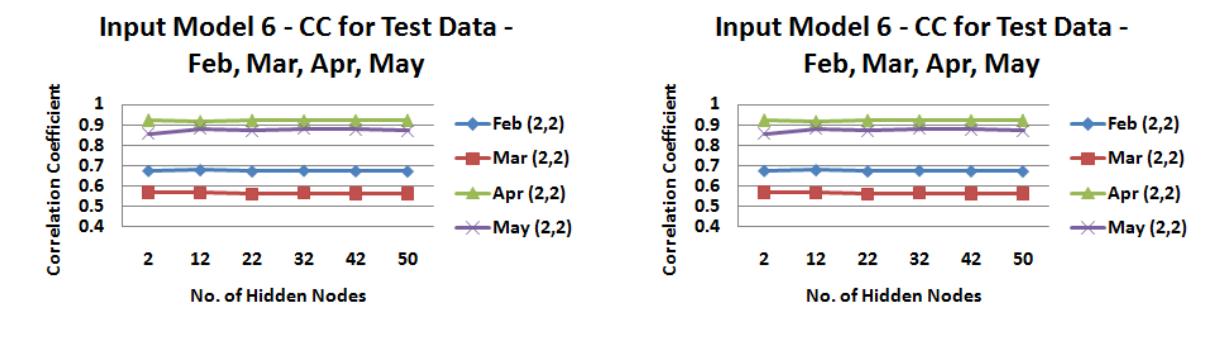
Figure 19. Correlation coefficients and mean absolute errors for input model 6 (3,3) when tested on data from individual months—February, March, April, May—( a ) Correlation Values ( b ) Error